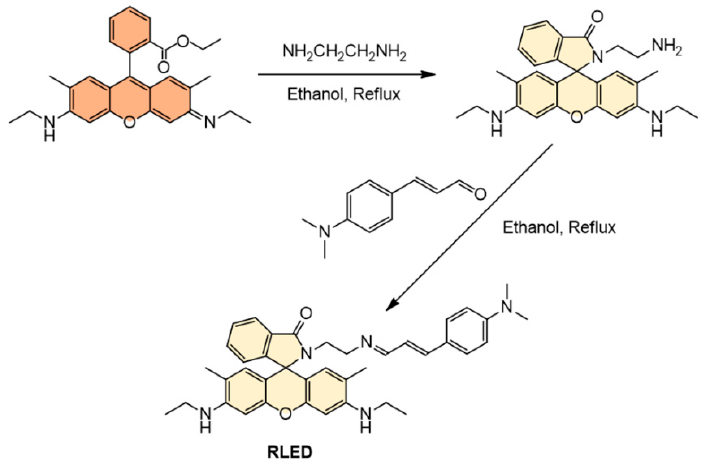
Scheme 2. Synthesis scheme for RLED.